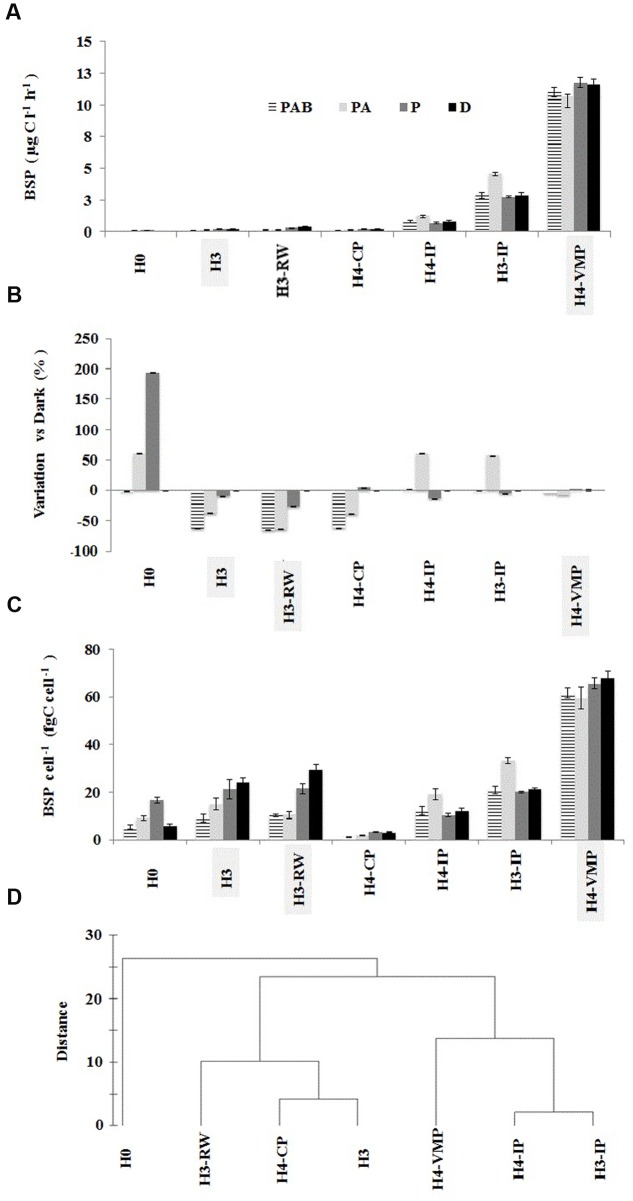
Bacterial secondary production (BSP) experimental response to solar radiation at seven stations in Salar de Huasco. Error bars represent standard deviation. The BSP samples from each sampling site were incubated under four different solar conditions: Full sun (PAB treatment), no UVB (PA treatment), no UV (PAR treatment), and no light exposure (dark treatment). (A) Average BSP under solar radiation treatments expressed as μg C l-1 h-1. (B) Variation of BSP as percentage of dark treatment (C). BSP cell-1 (as proxy of growth efficiency) expressed as fg C cell-1 h-1. (D) Group average cluster of station similarity based on BSP response to different solar radiation treatments.